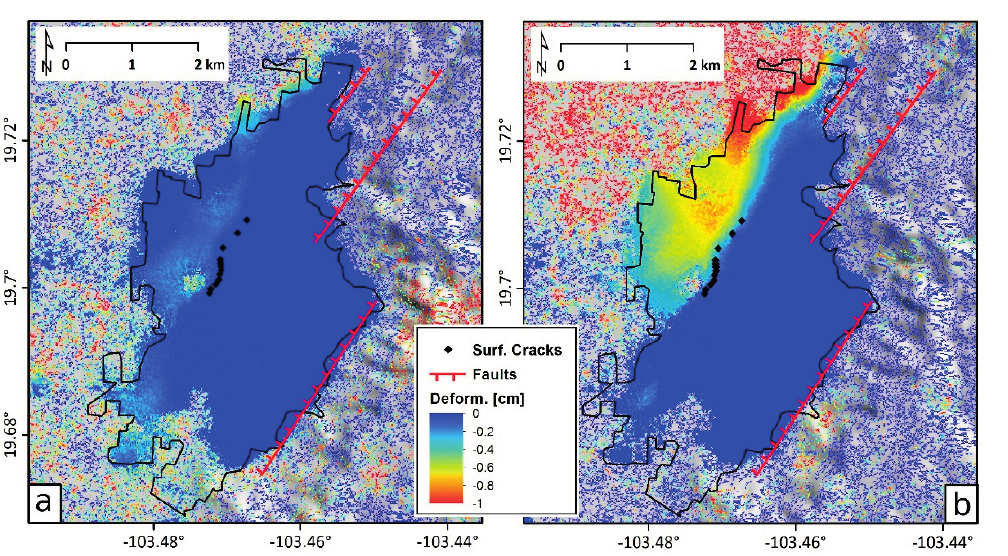
Figure 8. Pre event deformation estimated by exploiting 2012 RADARSAT-2 images: